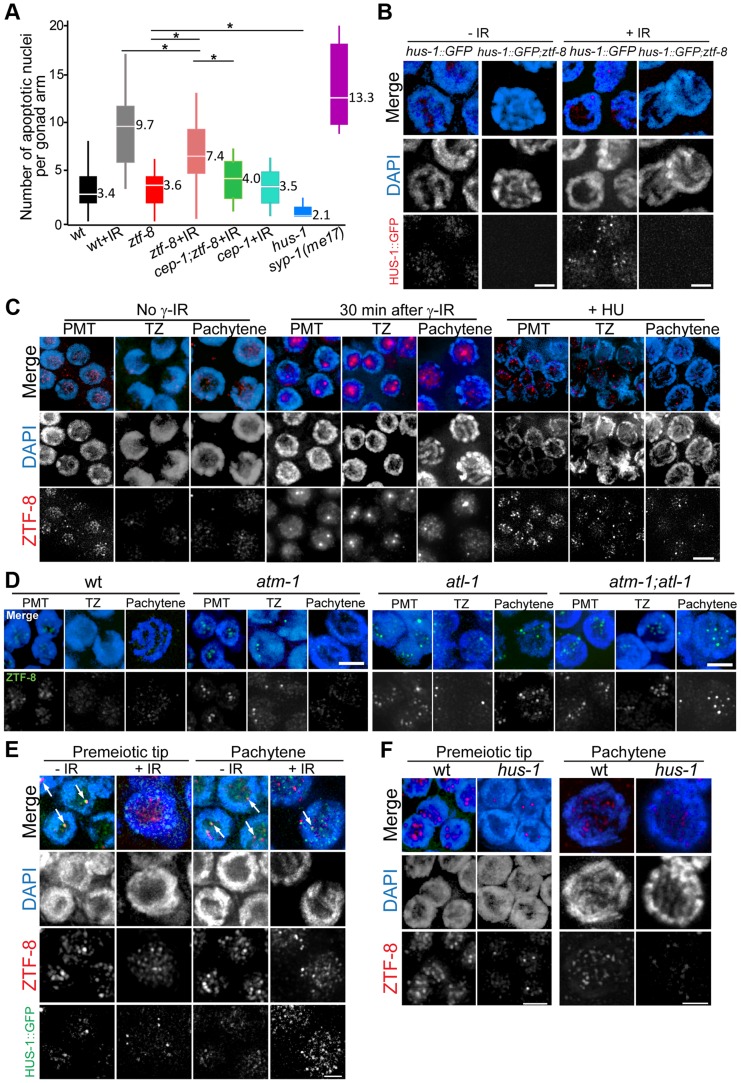
ZTF-8 is required for the 9-1-1 mediated meiotic DNA damage response and ZTF-8 localization requires both ATL-1 and ATM-1.
A. Quantification of germline apoptosis in the indicated genotypes. +IR indicates treatment with γ-irradiation (80 Gy). syp-1(me17) is a synapsis-defective mutant with elevated germ cell apoptosis levels (MacQueen et al., 2002) utilized as a positive control. Asterisks indicate statistical significance. P = 0.004 for wt+IR and ztf-8+IR, P<0.0001 for all others, by the two-tailed Mann–Whitney test, 95% C.I. B. Expression of a HUS-1::GFP transgene in pachytene nuclei of either wild type or ztf-8 mutants. C. Immunofluorescence images of nuclei stained with DAPI and anti-ZTF-8 prior to exposure to γ-IR, 30 minutes after γ-IR exposure (50 Gy), or exposed to 10 mM HU. Pre-meiotic tip (PMT), transition zone (TZ) and pachytene nuclei are shown. D. Immunofluorescence images of nuclei stained with DAPI and anti-ZTF-8 in wild-type, atm-1, atl-1, and atm-1;atl-1 mutant backgrounds. E. Co-immunostaining with anti-ZTF-8 and HUS-1::GFP signal expressing worms either unexposed (-IR) or exposed (+IR) to 100 Gy of γ-irradiation. Germline nuclei being depicted are from worms 8 hours after γ-IR exposure to capture bright HUS-1::GFP foci as described in [8]. Arrows indicate overlapping ZTF-8 and HUS-1::GFP signals. F. Immunofluorescence images of nuclei stained with DAPI and anti-ZTF-8 in wild type and hus-1 mutants. Bars, 2 µm.